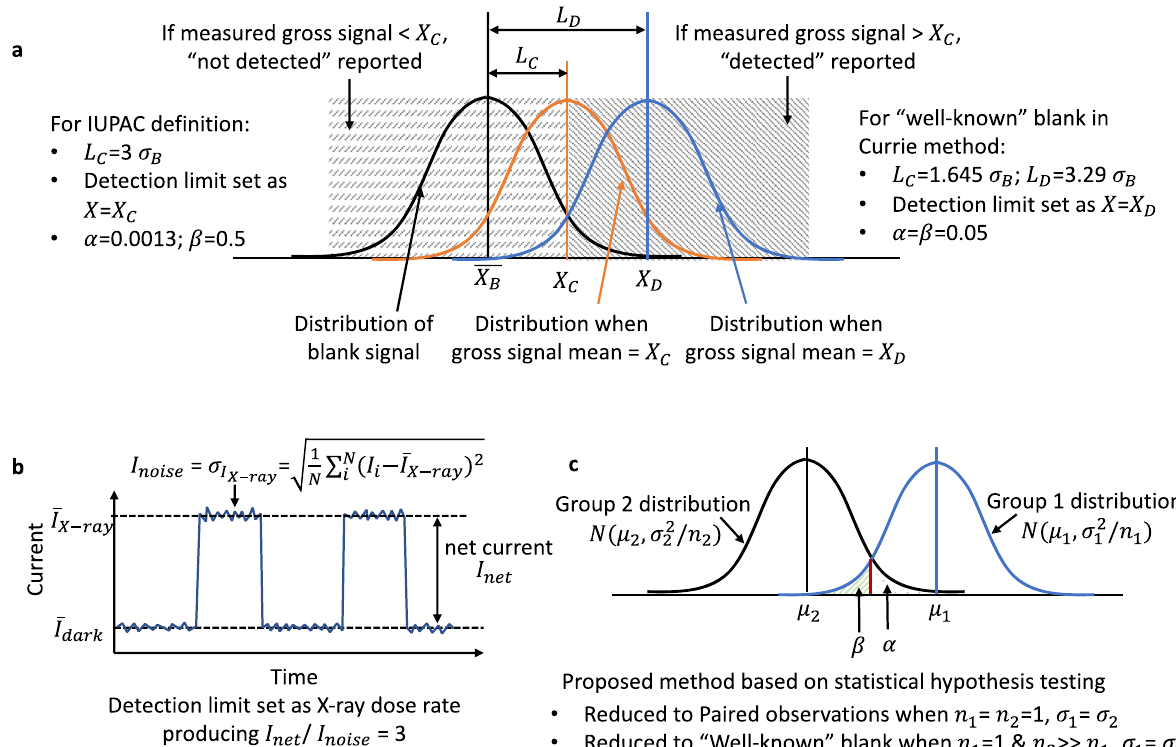
Fig. 2 Review and comparison of different methods for detection limit determination. a The “ Well-known ” blank in the Currie method and the IUPAC de fi nition. L C , critical level; L D , detection limit; σ B , blank signal standard deviation; α and β , type I and type II error; X D , smallest detectable gross signal; (cid:2) X B , mean of the blank signal. b The practiced way 27 – 29 for perovskite detector dose rate detection limit determination. N is the total number of digitized electric current data points and I i is the i th point. c The method proposed in this work, which is reduced to the Currie method with certain pre-assumptions. ( μ 1 , ; σ 2 n ), ( μ 2 , n 2 ; σ 2 ) are the means, sample sizes, and variances of the two respective groups following Normal 1 1 2